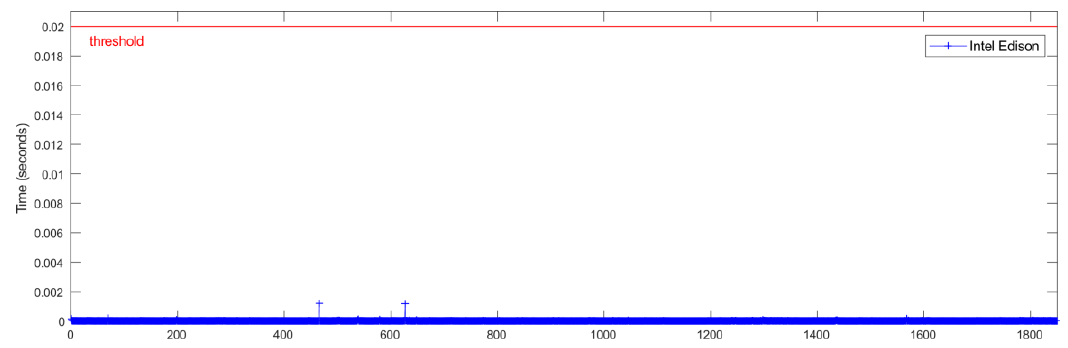
Figure 8. Test 1. Processing time of each iteration for Intel Edison. Table 4. Test 1. Processing time on Raspberry Pi 3 Model B and Intel Edison. Processing Time